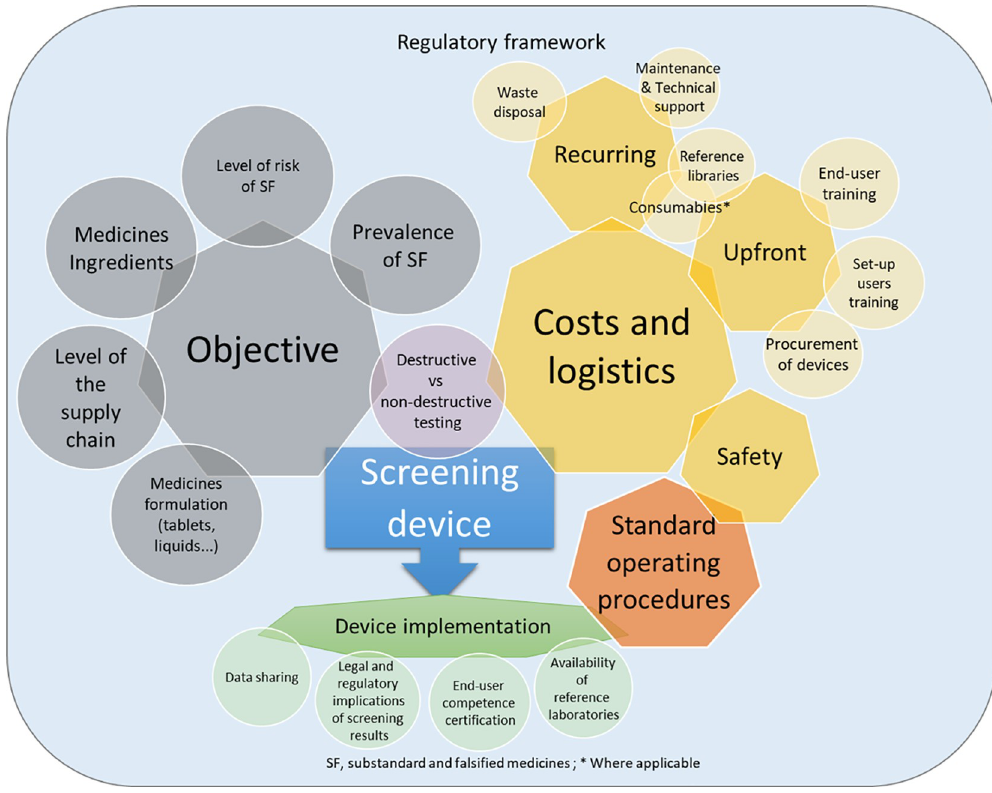
Fig 1. Major proposed considerations for the selection and implementation of medicine quality screening device. Each circle represents a key consideration when purchasing a screening device, grouped by themes (represented by heptagons). When the shapes overlap, the considerations are connected. For example, standard operating procedures are needed for the implementation of devices and should include measures for user safety. The circle diameters are illustrative.